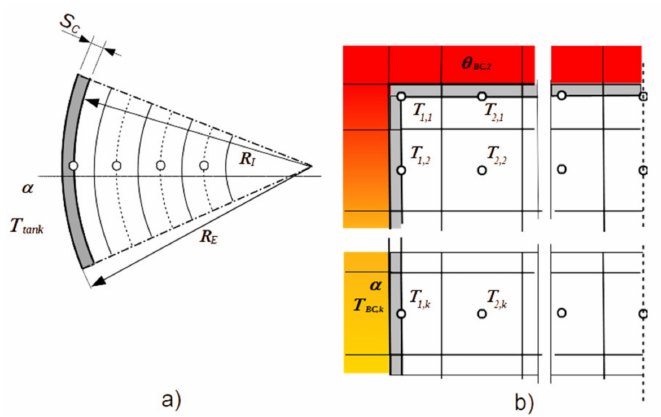
Figure 16. Numerical discretization of the PCM module with container thickness. ( a ) Top view, ( b ) symmetry plane